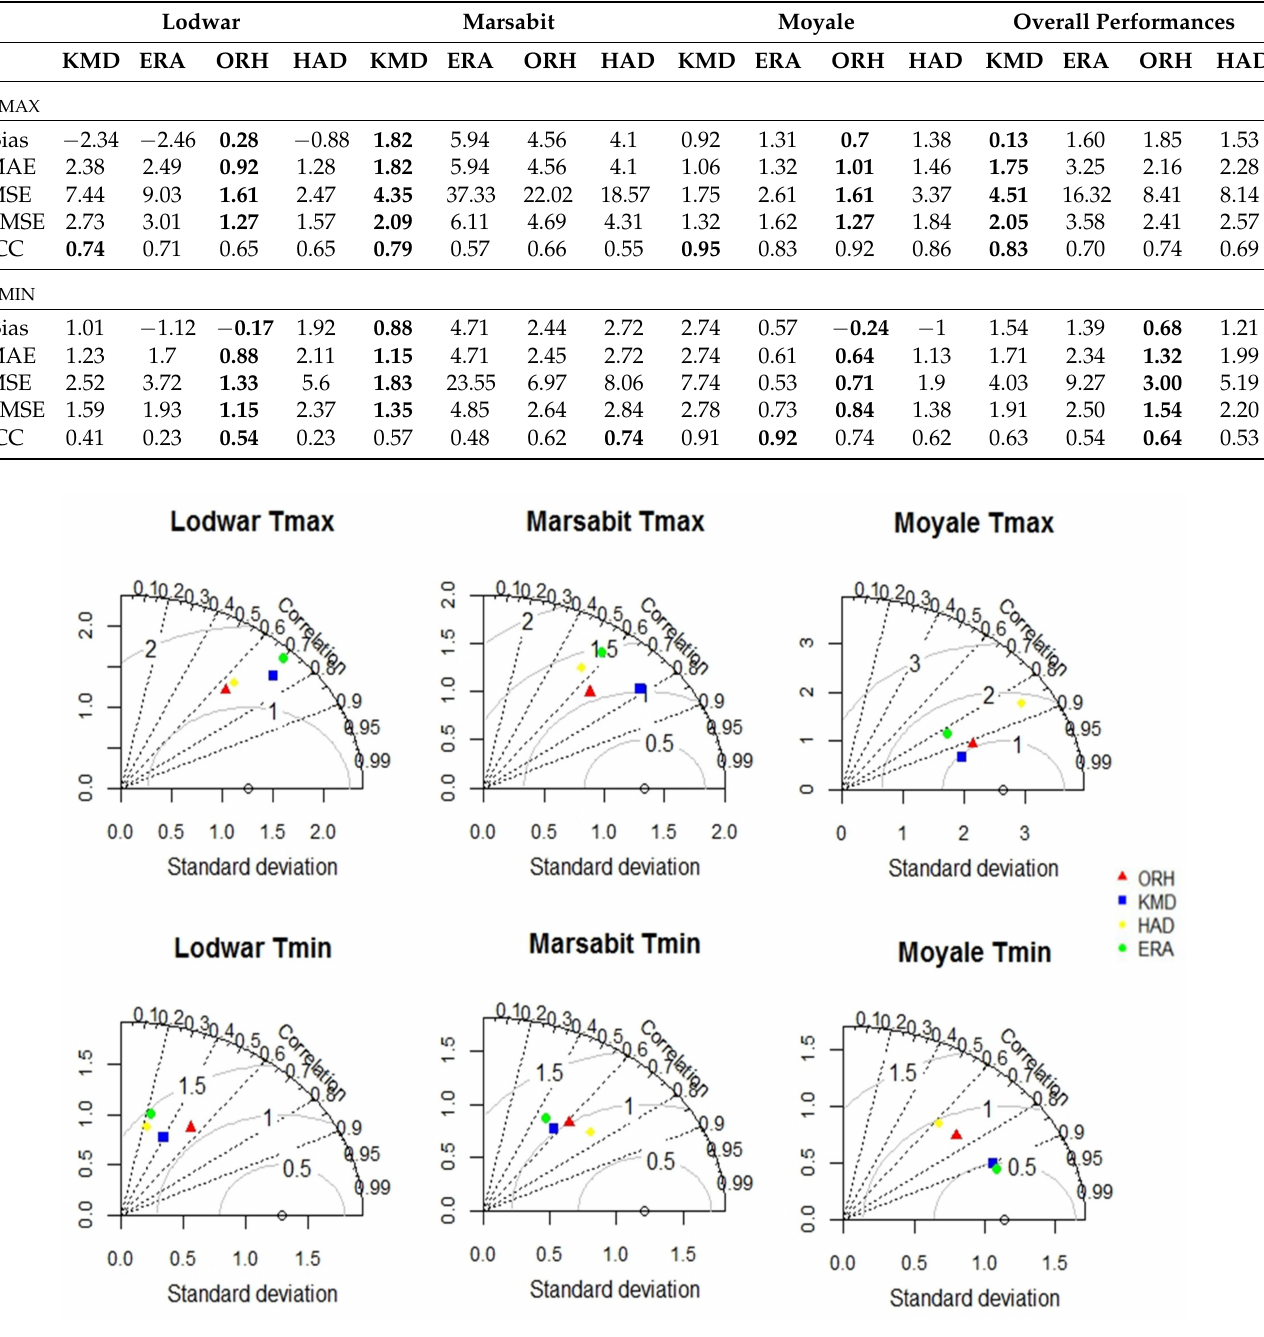
Figure 5. Taylor diagrams showing the agreement between the observed historical series and the temperature dataset for the selected land-based meteorological stations for the period 1983–2014. The standard deviation of each series is proportional to the distance from the origin of the diagram. The correlation coefficient (in Table 2) between each series and the observed historical series is expressed by the azimuthal angle. Points closer to the historical series’ marker (white point), with similar standard deviation and higher CC, correspond to the best-fit